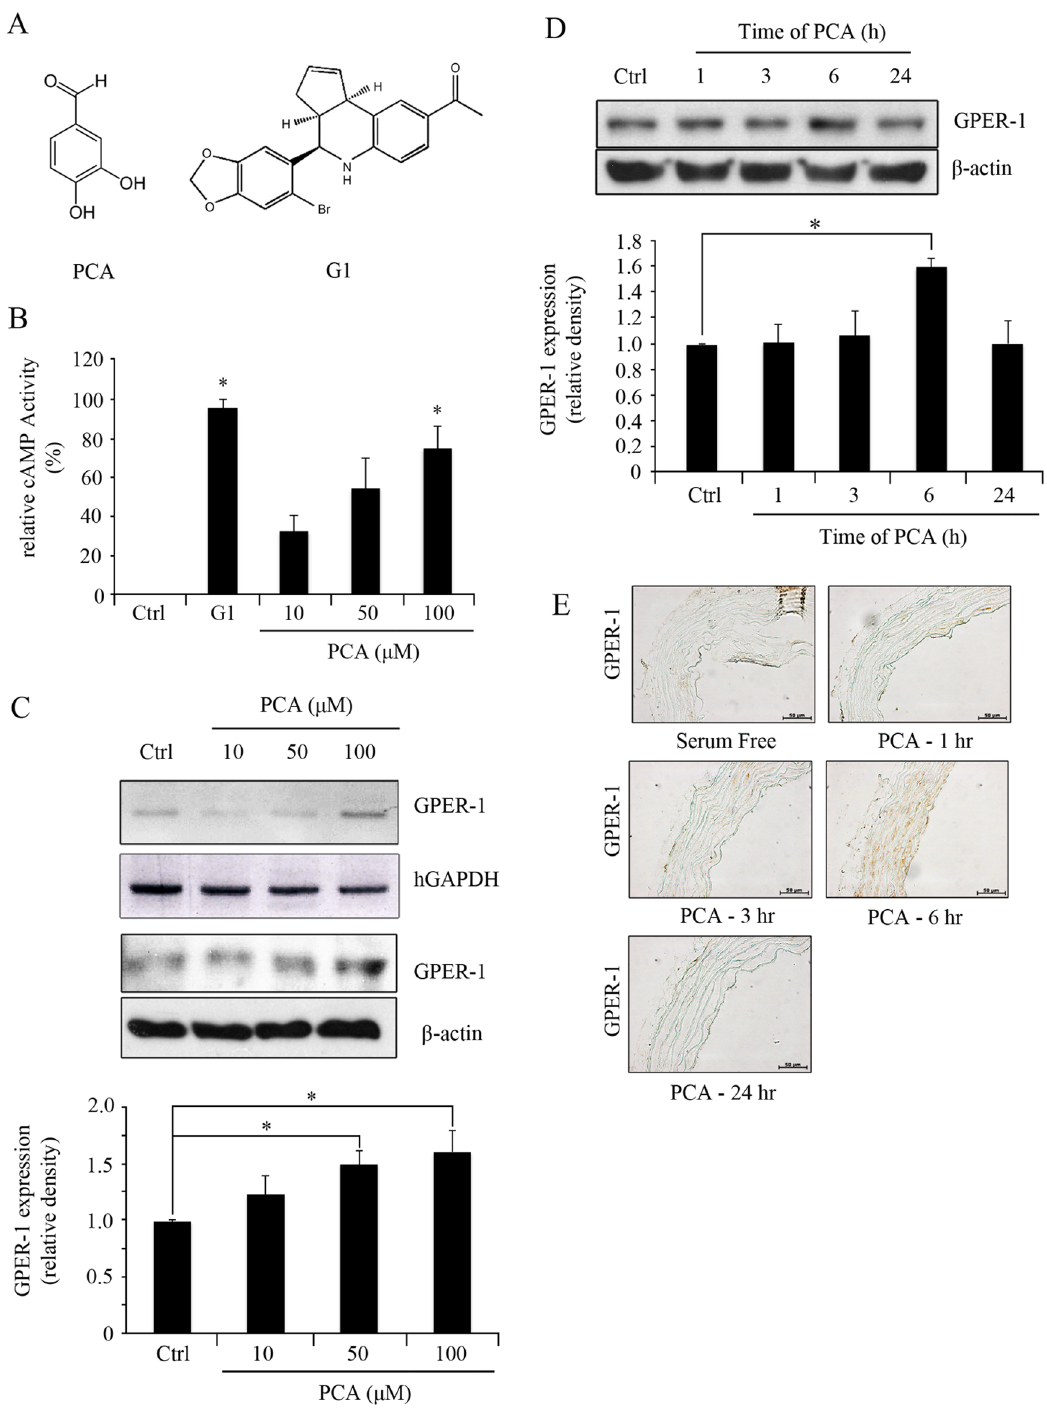
Figure 1. PCA induces expression of GPER-1. ( A ) The chemical structure of PCA and G1. ( B ) HUVECs were treated with G1 (3.0 m M) and PCA (10, 50, or 100 m M) for 1 hr to measure the levels of cAMP activity. ( C ) HUVECs were treated with PCA (100 m M) over 1, 3, 6, 24 hrs. ( D ) HUVECs were treated with PCA (10, 50, or 100 m M) for 6 hrs. Blots are representative of 3 independent experiments. Densitometric analyses are presented as the relative ratio of GPER-1 to b -actin. Data are presented as mean 6 SEM; * P , 0.05. ( E ) Aortic segments were harvested from Sprague Dawley rats and cultured ex vivo in serum-free media with PCA (100 m M) over 1, 3, 6, 24 hrs. Segments were than fixed for immunohistochemistry of GPER-1 using 4% paraformaldehyde.